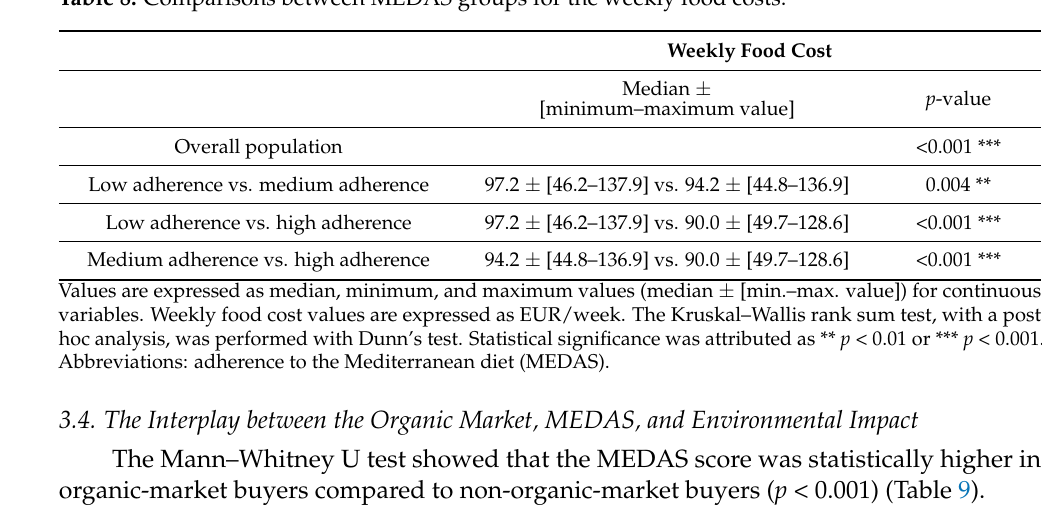
Table 8. Comparisons between MEDAS groups for the weekly food costs.